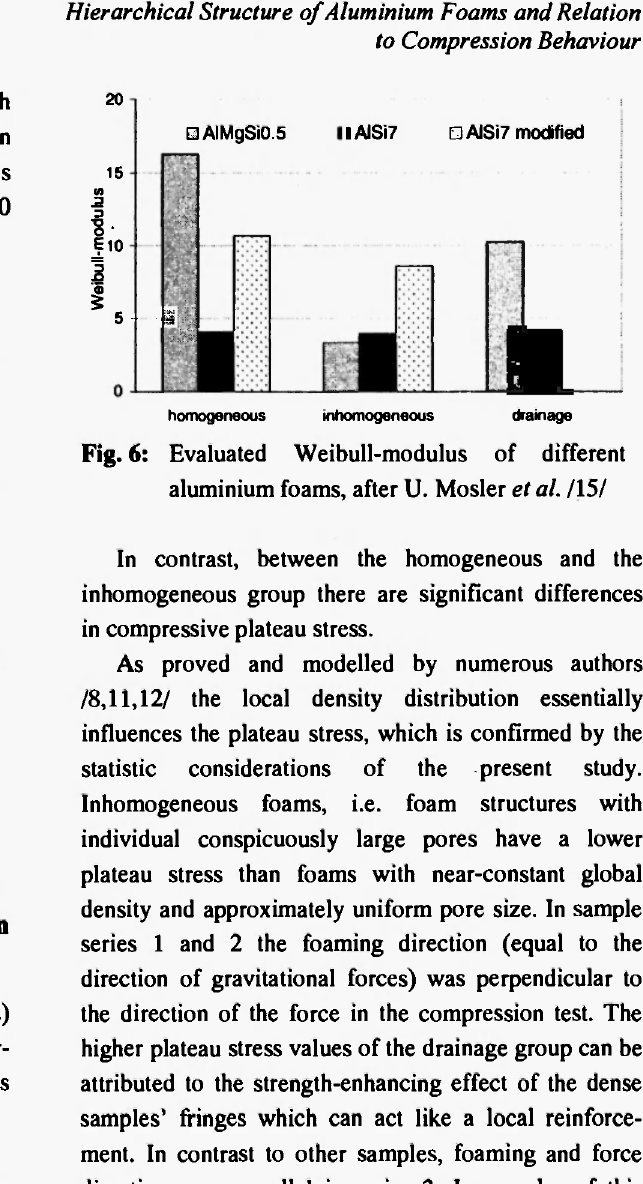
Fig. 4: Density-normalised stress versus strain of the wrought alloy AlMgSi0.5 (specimens with different global density).